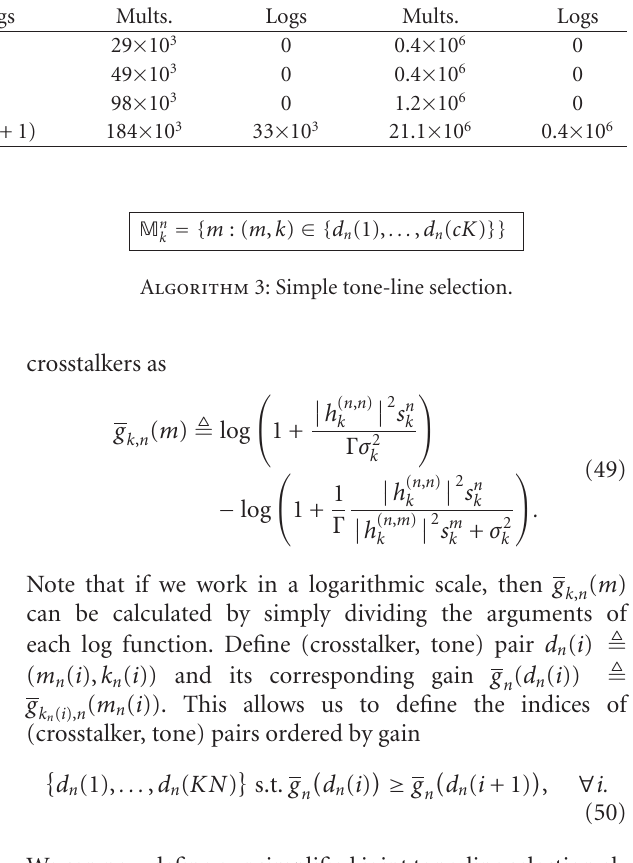
Table 1: Initialization complexity (mults. and log operations) of partial crosstalk cancellation algorithms (per user). Initialization complexity Scheme